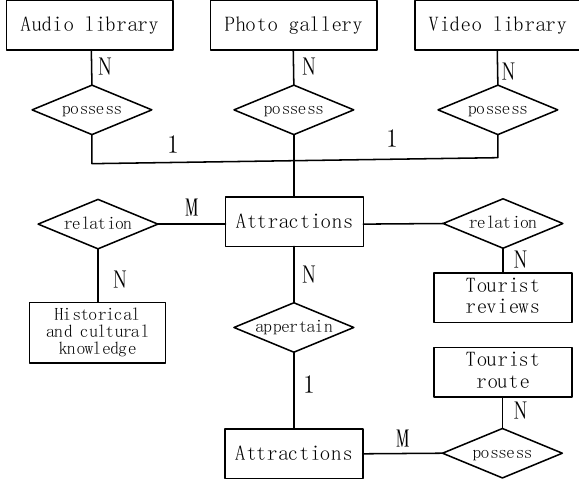
Figure 3. ER map of scenic spots related objects